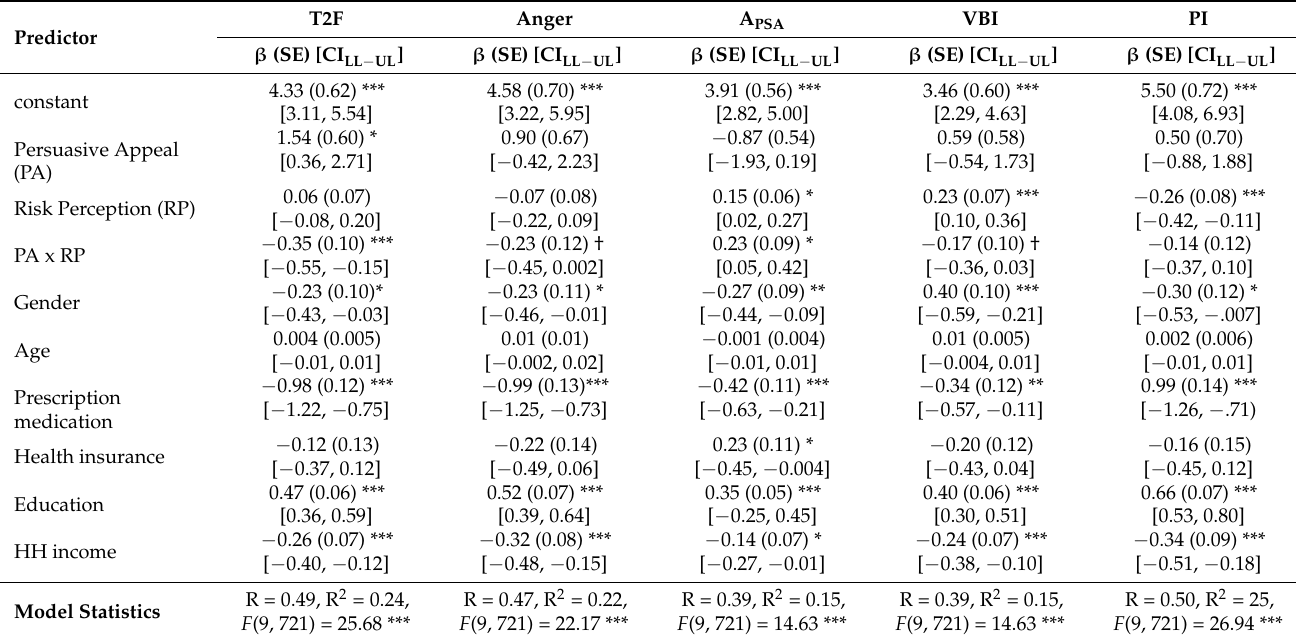
Table 2. Simple moderation analysis results for the effect of persuasive appeal on all DVs, moderated by risk